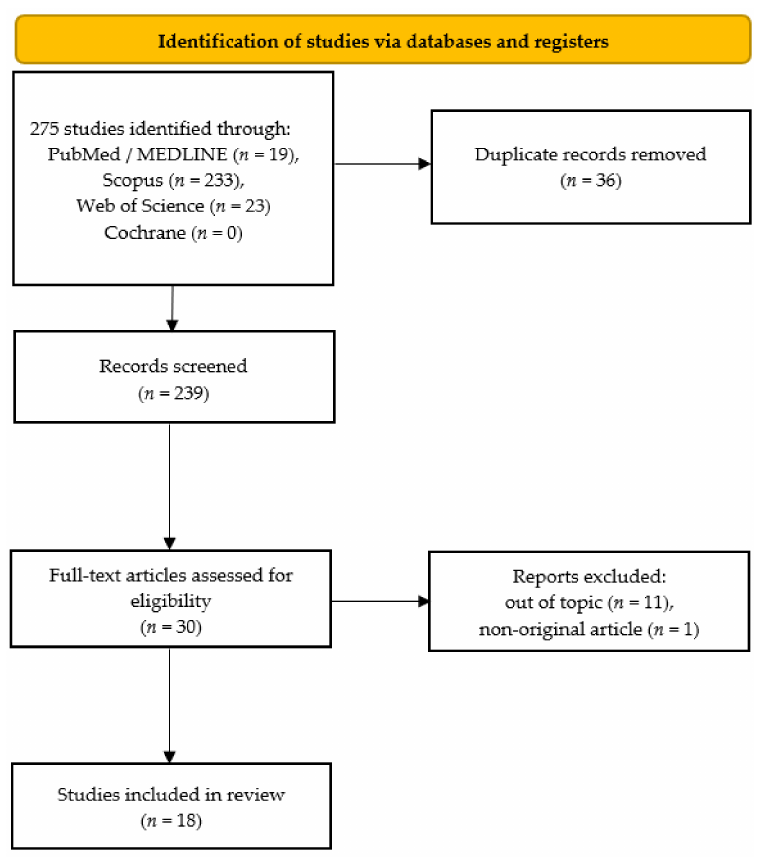
Figure 1. Flowchart of study